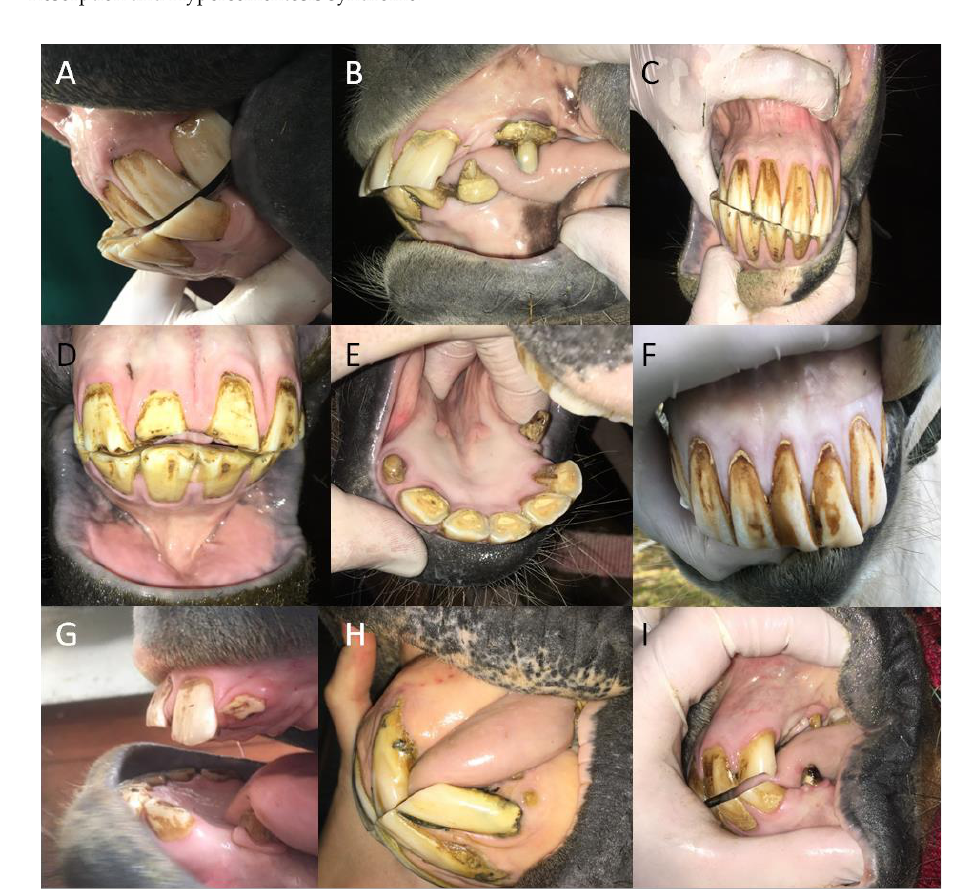
Figure 3. The samples of the malocclusions of the incisor teeth in horses. Underbite ( A ); overbite ( B ); curvature ( C ); diastema ( D ); oligodontia ( E ); polydontia ( F ); retained deciduous teeth (RDT) ( G ); the Equine Odontoclastic Tooth Resorption and Hypercementosis (EOTRH) syndrome ( H ); and hooks ( I ).